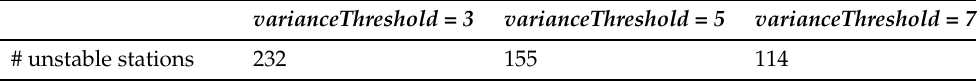
Table 7. Number of filtered unstable stations with variable varianceThreshold and fixed f